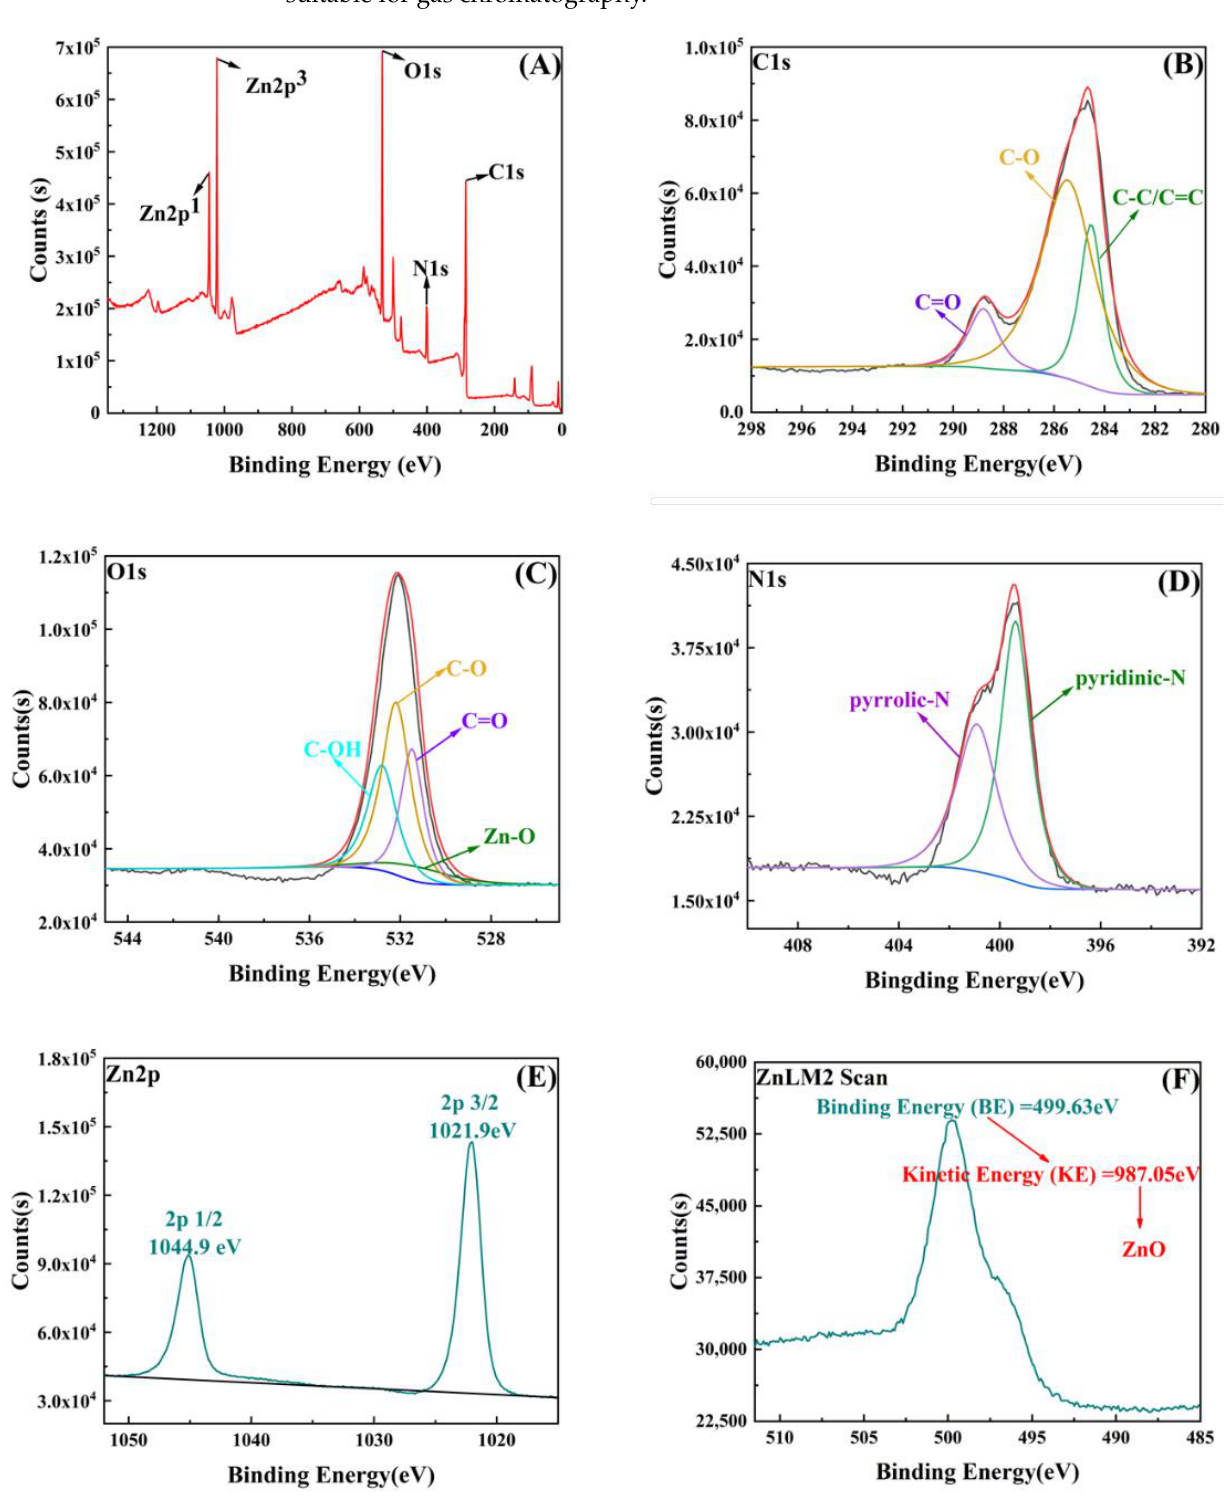
Figure 3. XPS spectra of the survey scan of ZIF-8/CA ( A ), C1s region ( B ), O1s region ( C ), N1s ( D ), Zn2p ( E ) region of ZIF-8/CA, and Auger electron spectrum of Zn ( F ).